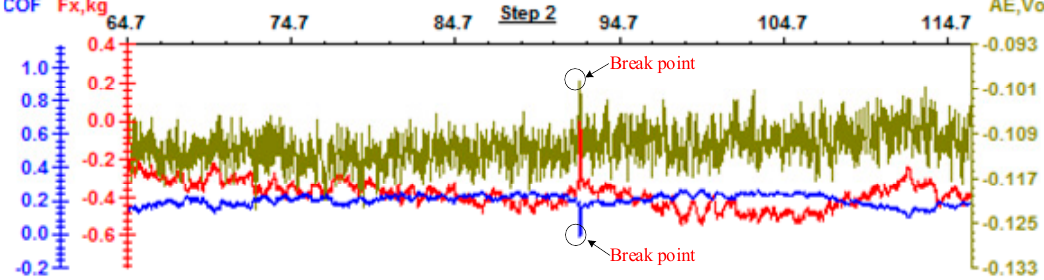
Figure 7. The change of tangential load F x , friction coefficient µ and acoustic signal AE with time t .